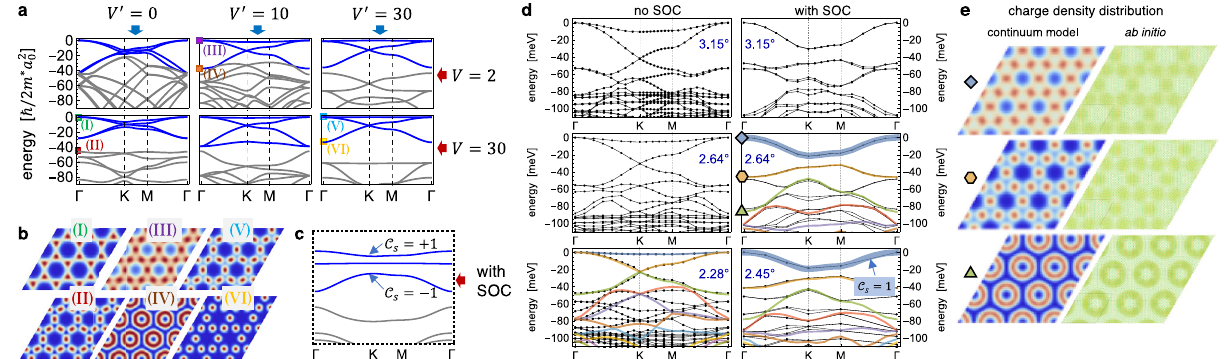
Fig. 2 Emergent Kagome lattice and continuum theory of twisted ZrS 2 bilayers. a Anatomy of the moiré band structure in the two-orbital pseudospin (cid:4) 1. In the absence of continuum theory, as a function of the scalar ( V ) and pseudospin ( V 0 ) potential, with η = 0.15 and energies normalized to _ = 2 m ? a 2 0 V 0 , a well-separated honeycomb lattice with two p orbitals per sublattice emerges with increasing V [bottom left], directly analogous to twisted bilayer graphene. b The calculated charge density of bands (I) is localized in a honeycomb pattern of AB/BA regions; however, the next lower-energy band (II) already exhibits a Kagome charge density pattern. Conversely, the pseudospin moiré potential V 0 favors charge patterns localized in (III) the Kagome “ X ” regions as well as on rings (IV) around the Kagome hexagons. As a 0 ~ θ − 1 , an energetically well-separated Kagome moiré band structure emerges at suf fi ciently small twist angles [ a , right column, marked in blue]. c Spin – orbit interactions lift the quadratic touching of Kagome bands at Γ . The resulting band structure is gapped and realizes a novel Kagome moiré fl at-band quantum spin Hall insulator with spin Chern numbers ± 1 of the top and bottom Kagome bands. d depicts the ab initio band structure of twisted bilayers for three representative twist angles with [right column] and without [left column] spin-orbit coupling, with the top-most valence bands arising from the emergent Kagome lattice. Colored lines indicate the continuum model band structure, fi tted to the top valence bands [see main text]. Additional deeper p z orbital valence bands appear > 50 meV below the band edge and are not accounted for in the continuum theory, however are progressively separated energetically from the Kagome bands as the twist angle is reduced. Importantly, spin-orbit interactions split off a topological band with spin Chern number C s ¼ 1 [thick blue line], as discussed in the main text. e Matching charge density distributions from the pseudospin continuum theory and ab initio calculations con fi rm the emergent Kagome band